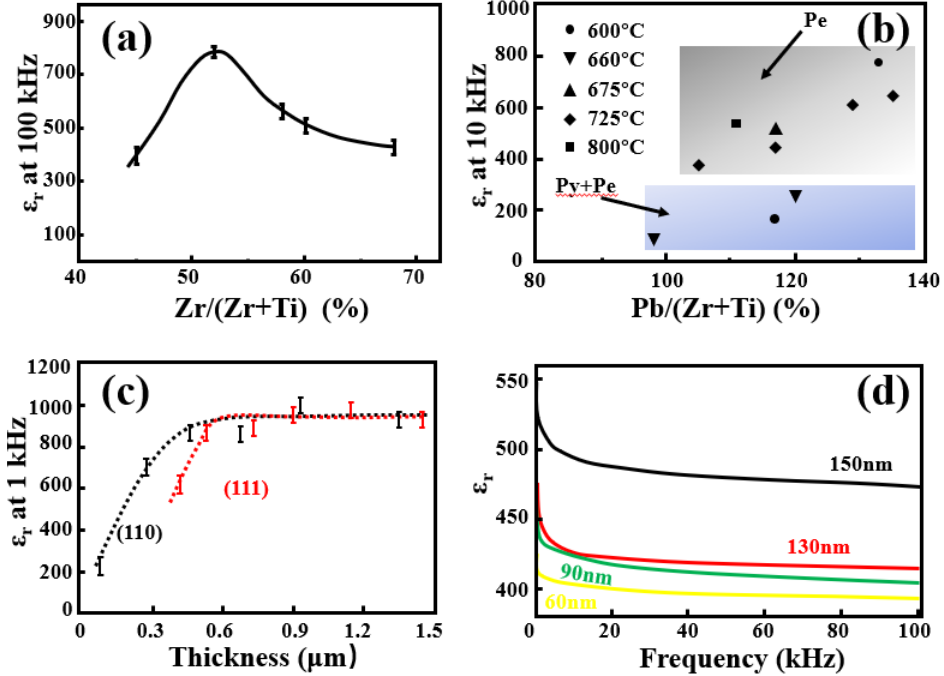
Figure 8. ( a ) Relations of relative dielectric constant ε r and Zr/Ti ratio in PZT thin films. Reprinted with permission from [55] Copyright 1989 Elsevier; ( b ) influences of Pb content on ε r . Reprinted with permission from [66] Copyright 1992 The Physical Society of Japan and The Japan Society of Applied Physics; ( c ) dependence of orientation and film thickness on ε r [69]; ( d ) effects of ε r on the grain size and frequency. Reprinted with permission from [70] Copyright 2002 Elsevier.